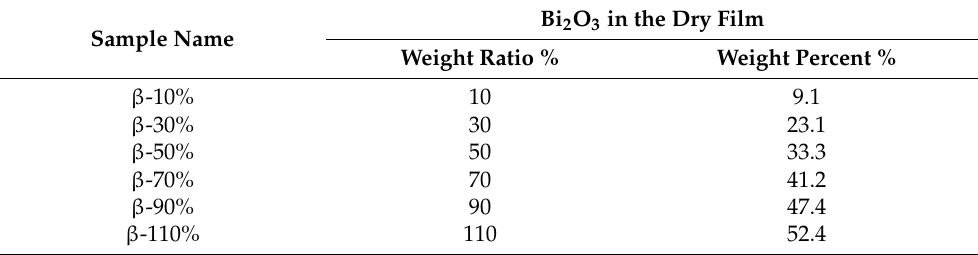
Table 1. Concentrations of Bi 2 O 3